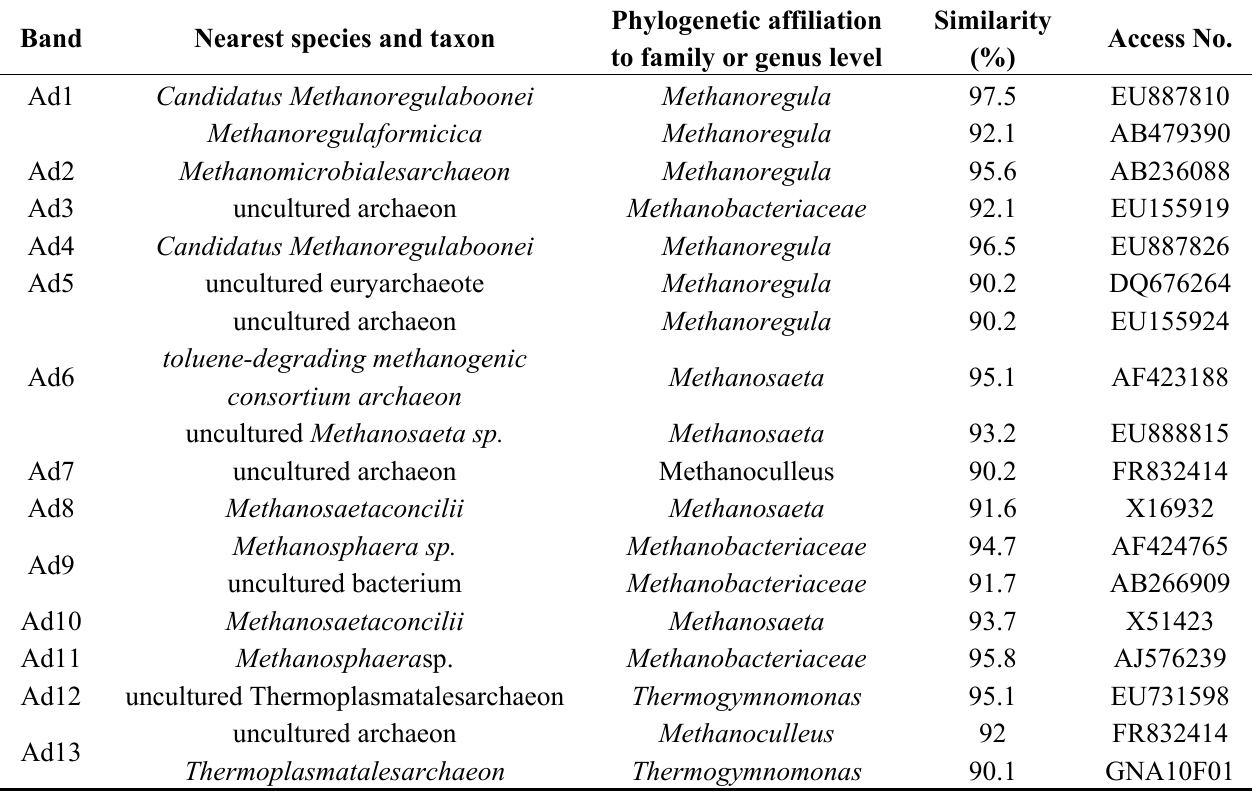
Table 2. Identity of the genomic sequences in the dominant DGGE bands obtained by sequencing and basic local alignment search tool (BLAST)